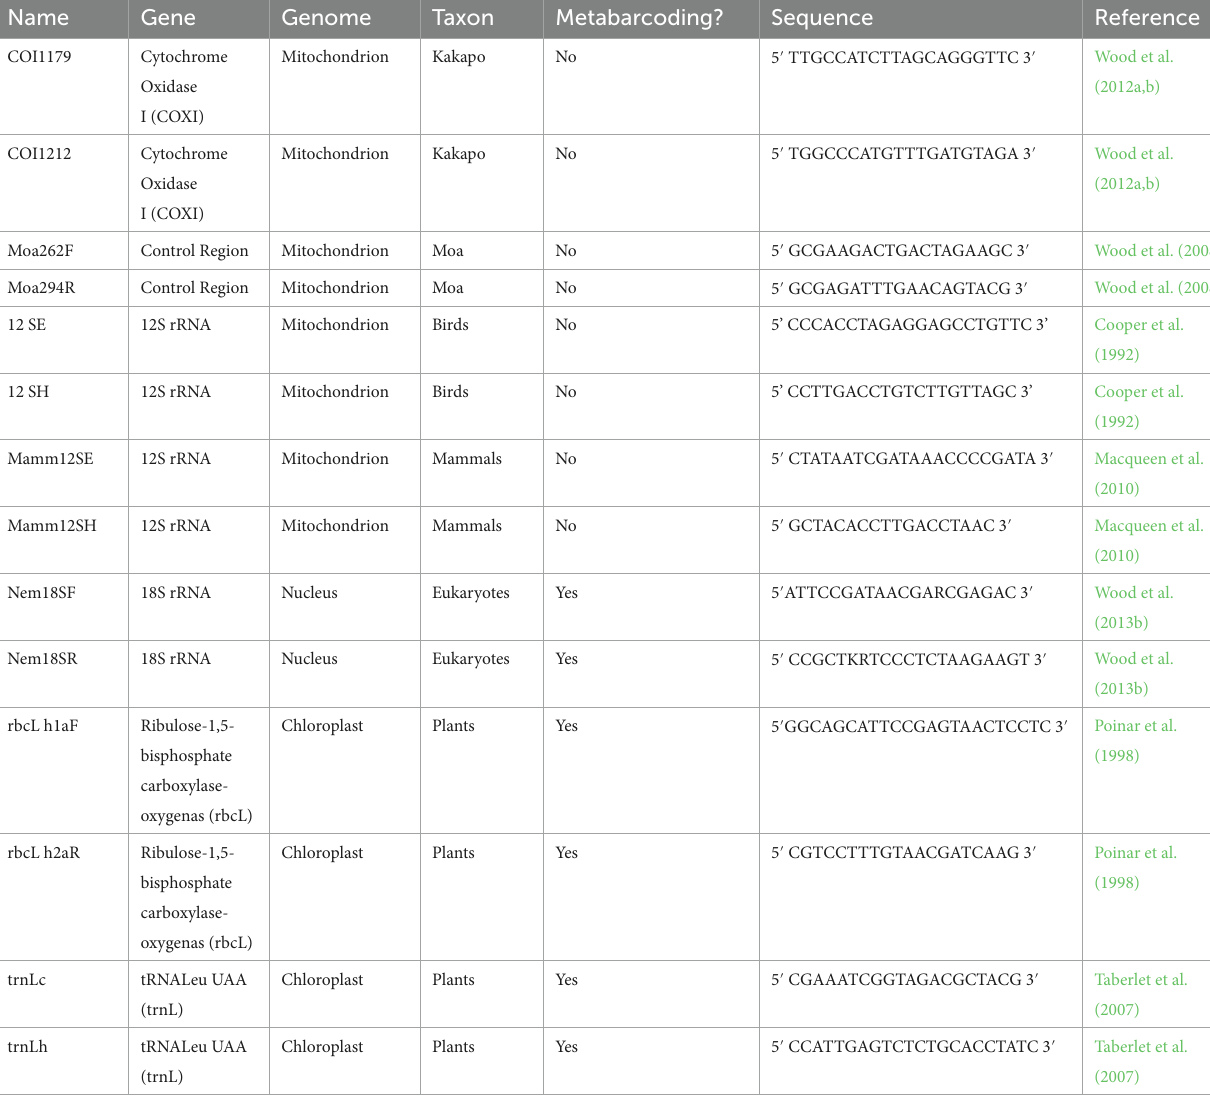
TABLE 3 List of all primers used in this